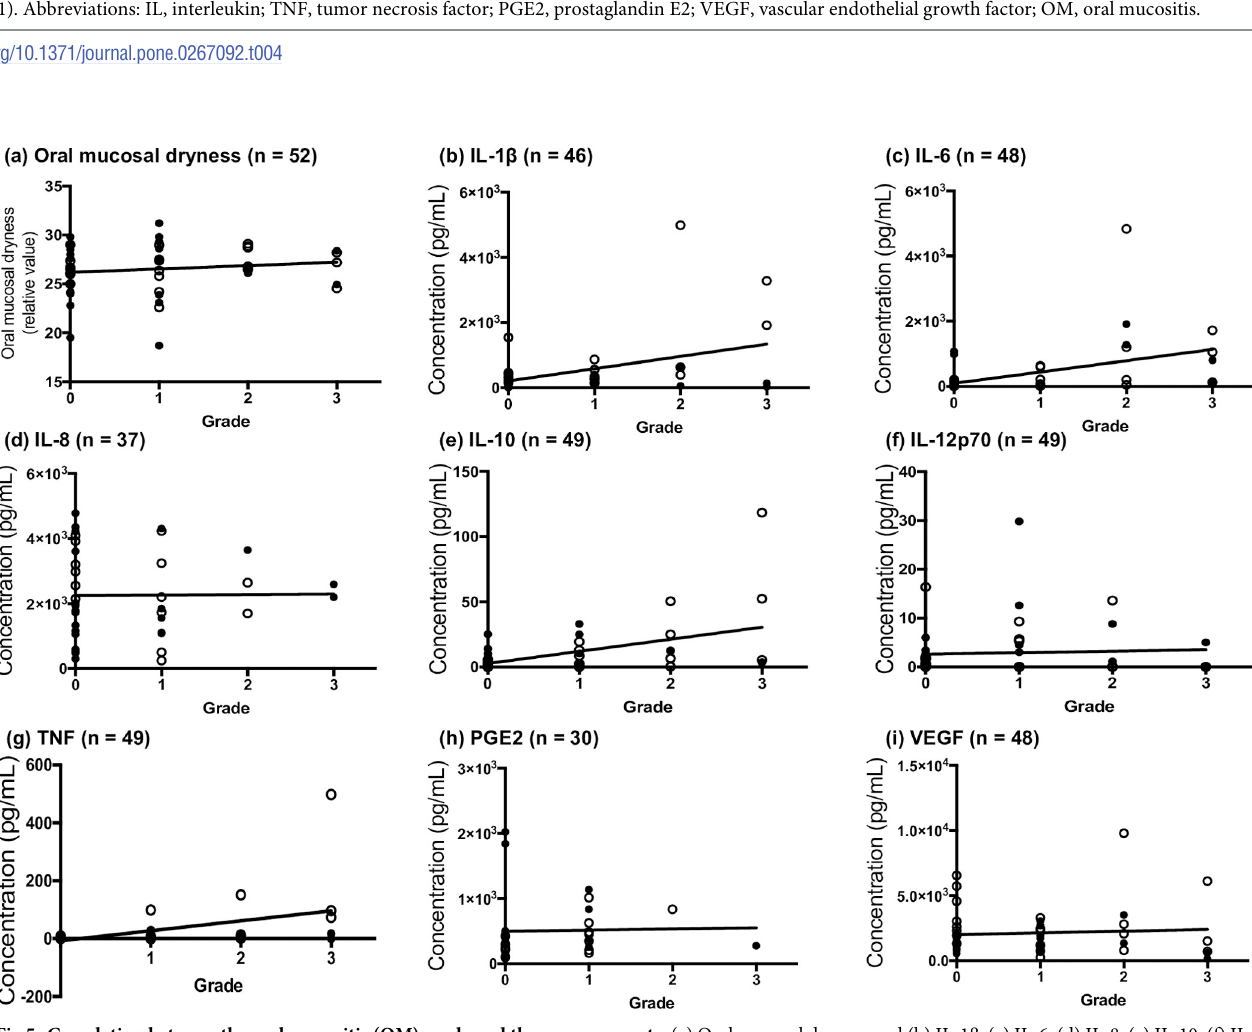
Fig 5. Correlation between the oral mucositis (OM) grade and the measurements. (a) Oral mucosal dryness and (b) IL-1 β , (c) IL-6, (d) IL-8, (e) IL-10, (f) IL- 12p70, (g) TNF, (h) PGE2, and (i) VEGF in the saliva of patients with cancer. The closed circles for the index groups represent patients with leukemia, while the open circles represent patients with head and neck carcinoma. The correlation of OM grade with each measurement is analyzed using Spearman’s r